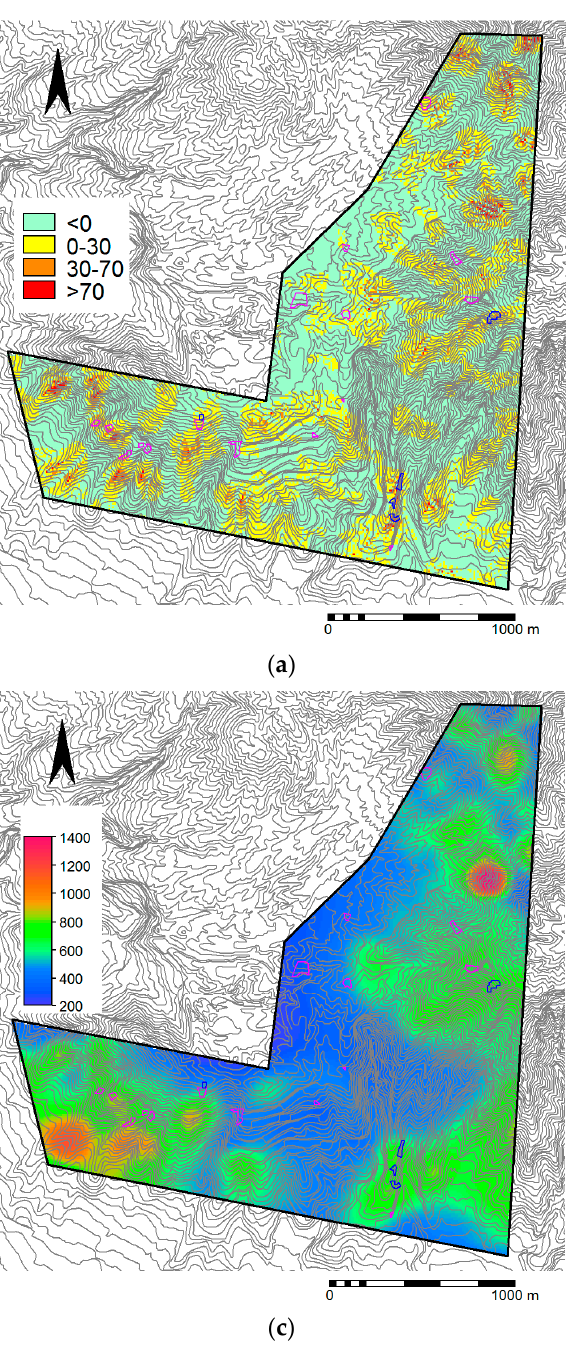
Figure 5. Parameters for calculating ISEL and ISEL distribution with landslides ( a ) Topographic index F calculated by using Equation (1) ( b ) Resistivity distribution ( c ) Average ruggedness of resistivity ( d ) ISEL. In blue—landslides at lava layer; in pink—landslide at volcanic tephra layers